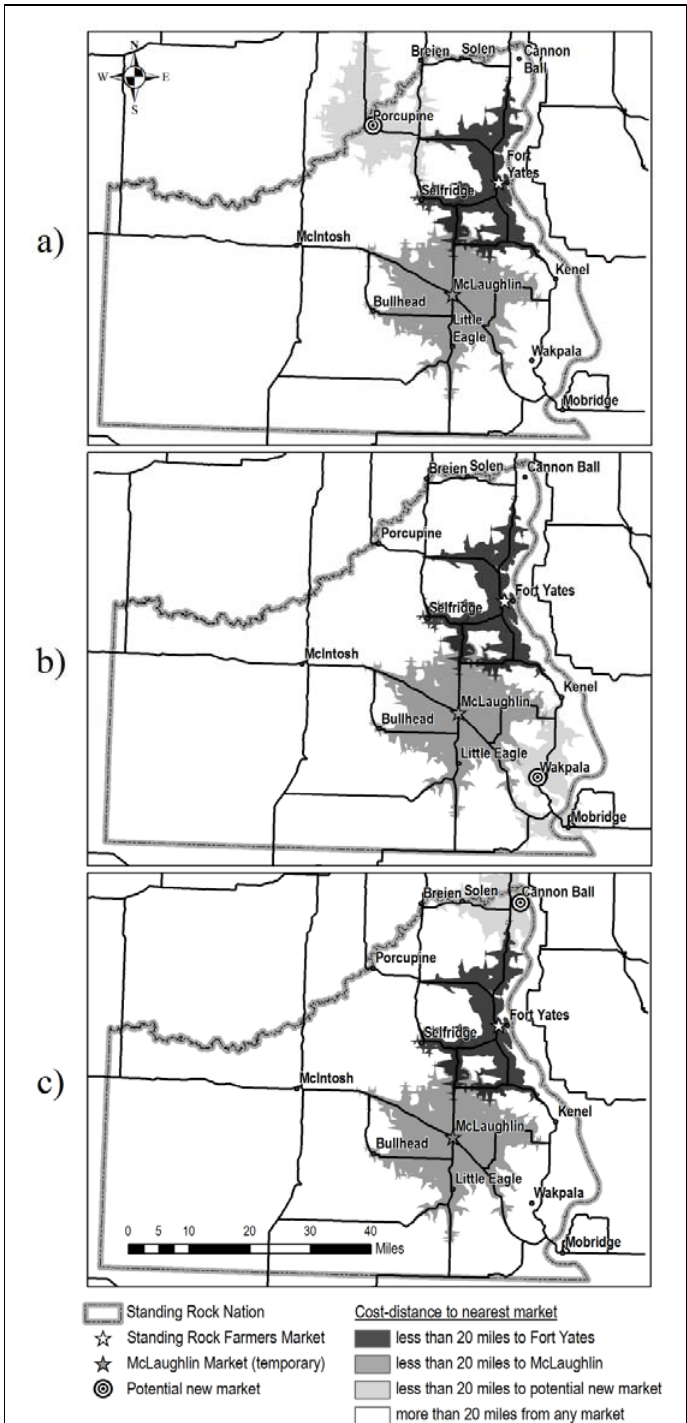
Figure 6. Comparison of Changes in Cost-Distances to Market with the Addition of Markets in (a) Porcupine, (b) Wakpaka, and (c) Cannon Ball